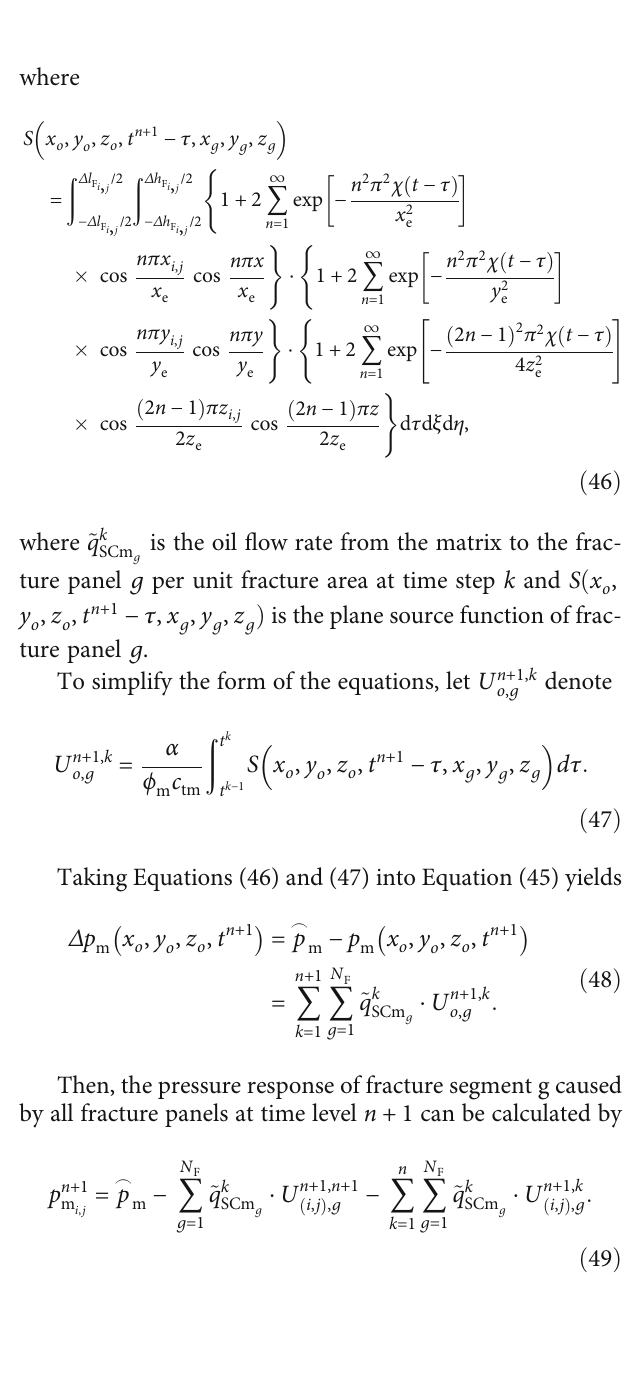
Figure 3: Basic parameters of fracture panel ( i , j